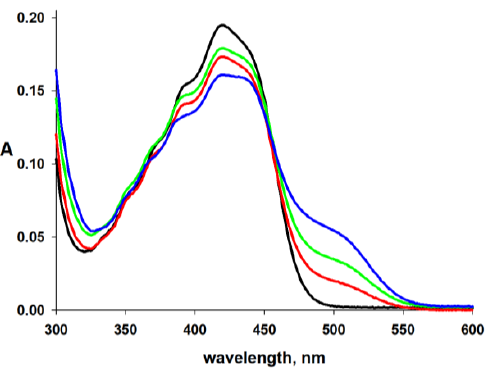
Figure 2. The UV-vis spectra of E- 1 (c = 0.015 M, d = 0.047 mm, black line) in the presence of 0.5 (red), 1 (green), and 2 (blue) equivalents of [AgPz] 3 ; CCl 4 , 298 K. 1 (green), and 2 (blue) equivalents of [AgPz] 3 ; CCl 4 , 298 In contrast, phenyl-substituted chalcone E- 2 does not possess charge transfer and exhibits only π → π * transitions demonstrating high-energy bands centered at ca. 320 nm